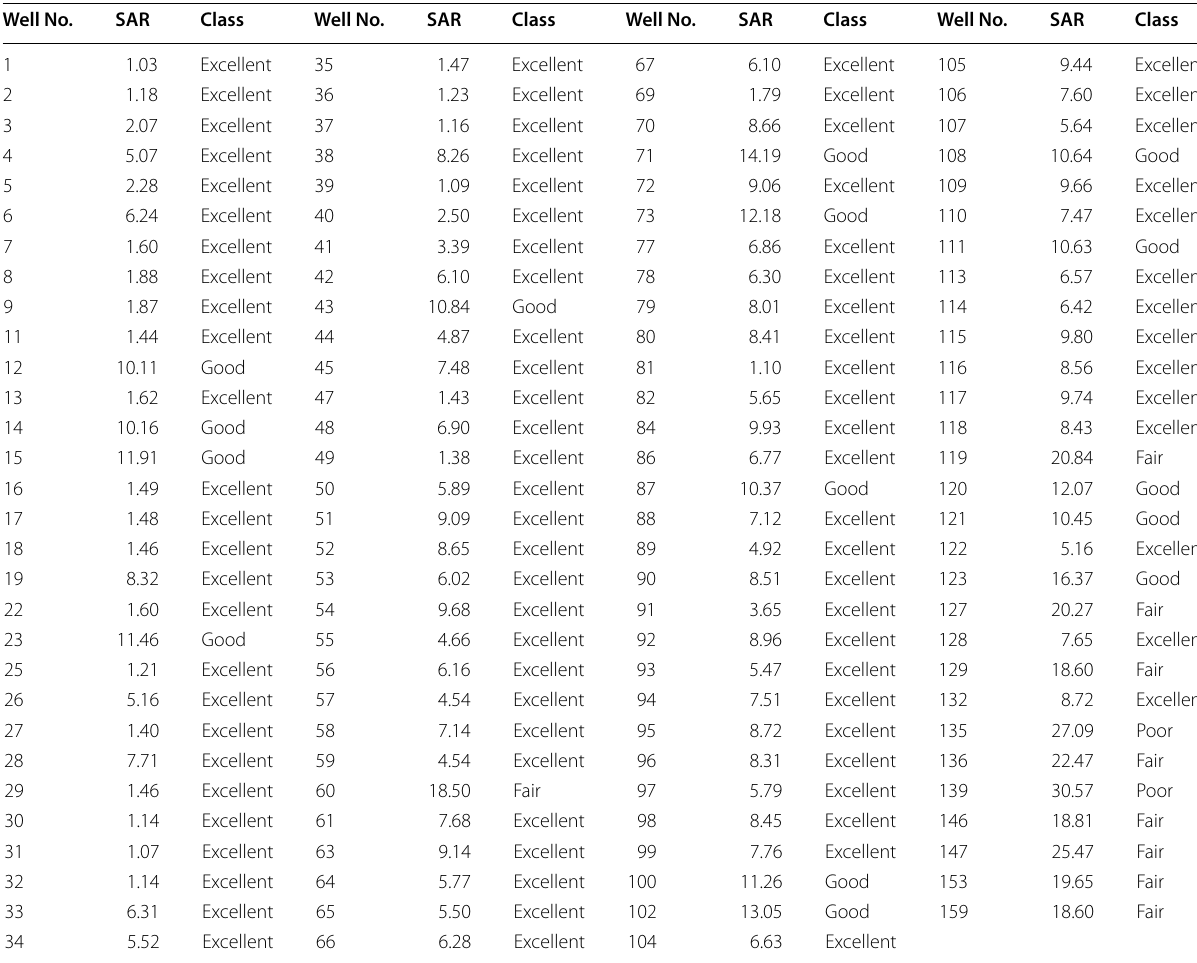
Table 9 Water quality according to sodium adsorption ratio (SAR) for the groundwater samples in the studied area Well No. SAR Well